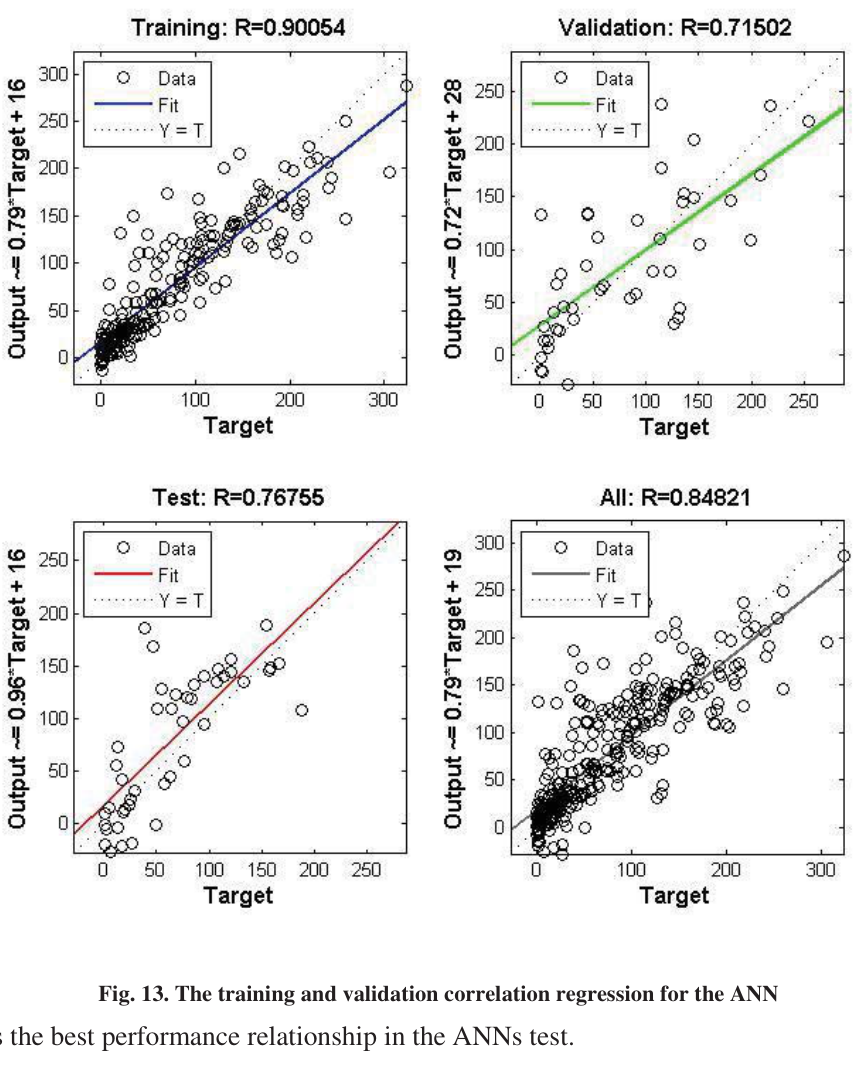
Fig. 13. The training and validation correlation regression for the ANN